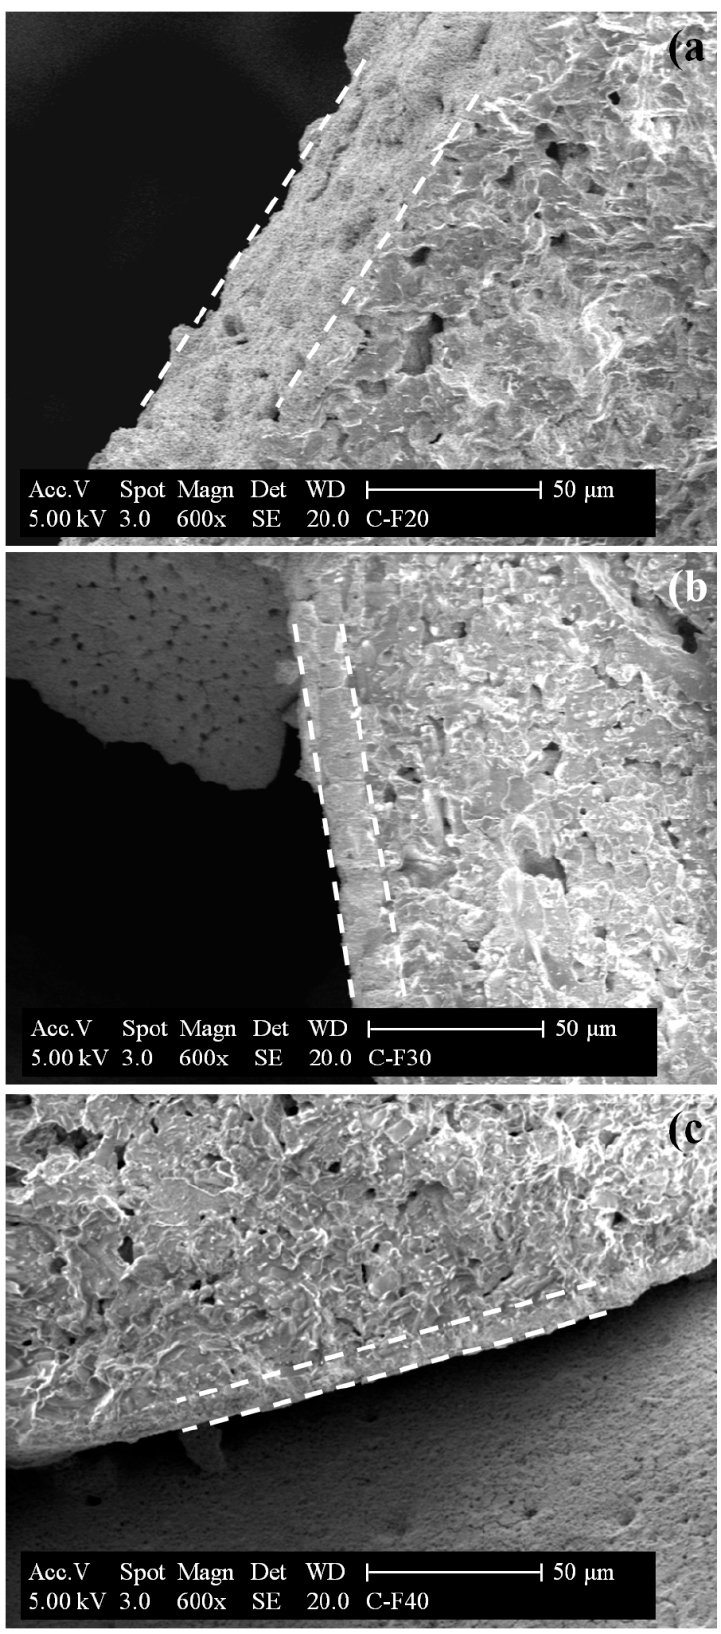
Figure 5. SEM images of 20 ppi ( a ), 30 ppi ( b ) and 40 ppi ( c ) coated